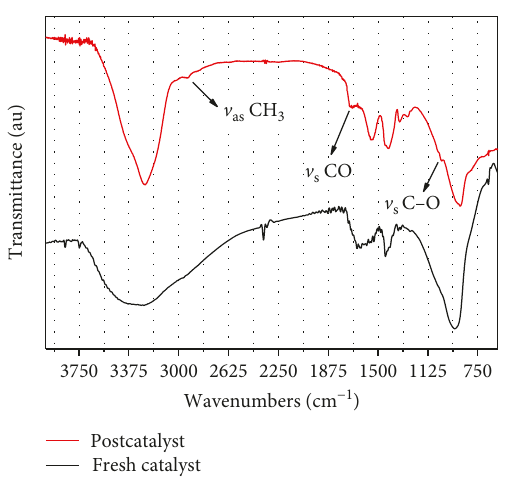
Figure 7: FTIR spectrum of the 10%TiO AP reaction shown in Figure